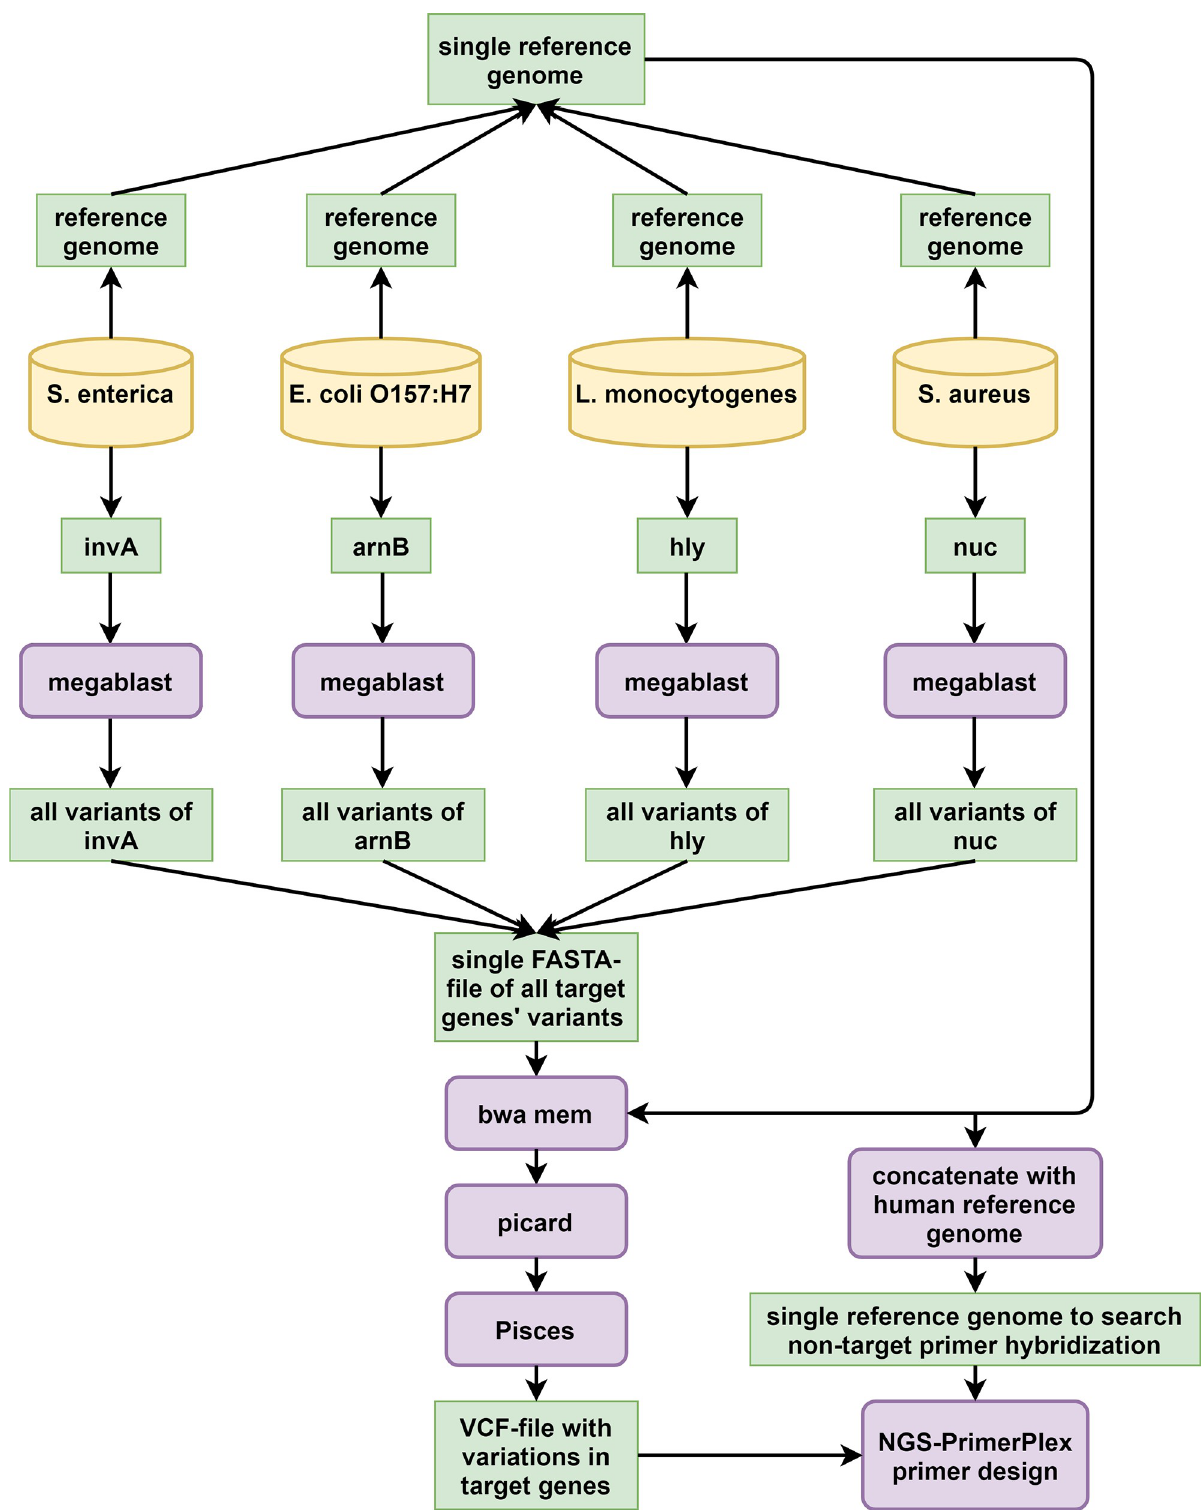
Fig 2. The primer design workflow for the foodborne bacterial pathogen detection.